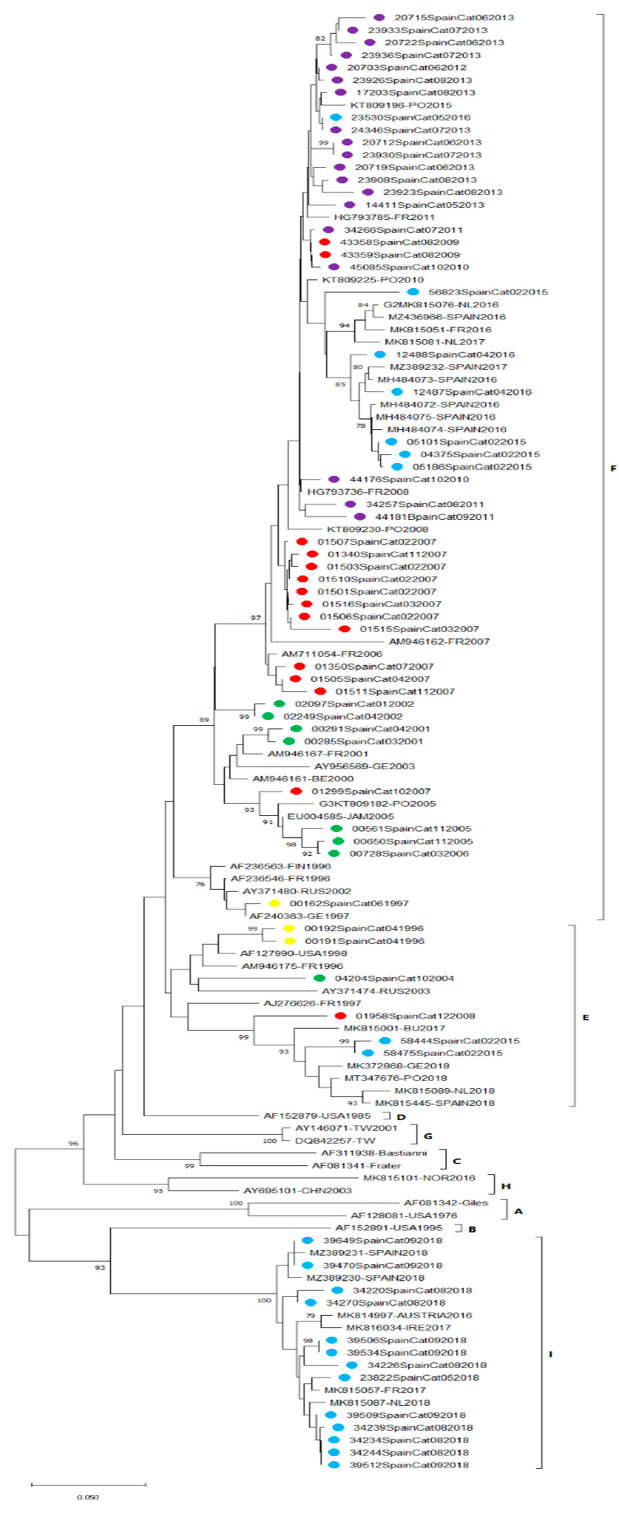
Figure 3. Phylogenetic tree of the 3 (cid:48) -VP1 region with E30 sequences from 1996–2020 classified into 9 lineages, A–I. The tree was reconstructed using the neighbor-joining method and the maximum composite likelihood model. The tree was rooted with the prototype sequences Bastianni (AF311938) and Frater (AF081341). Bootstrap resampling (1000 replicates) was used to determine grouping robustness. Values of >70% are shown. E30 sequences obtained in this study are colored according to the year of detection (yellow 1996–1997; green 2001–2006; red 2007–2009; violet 2010–2013; blue